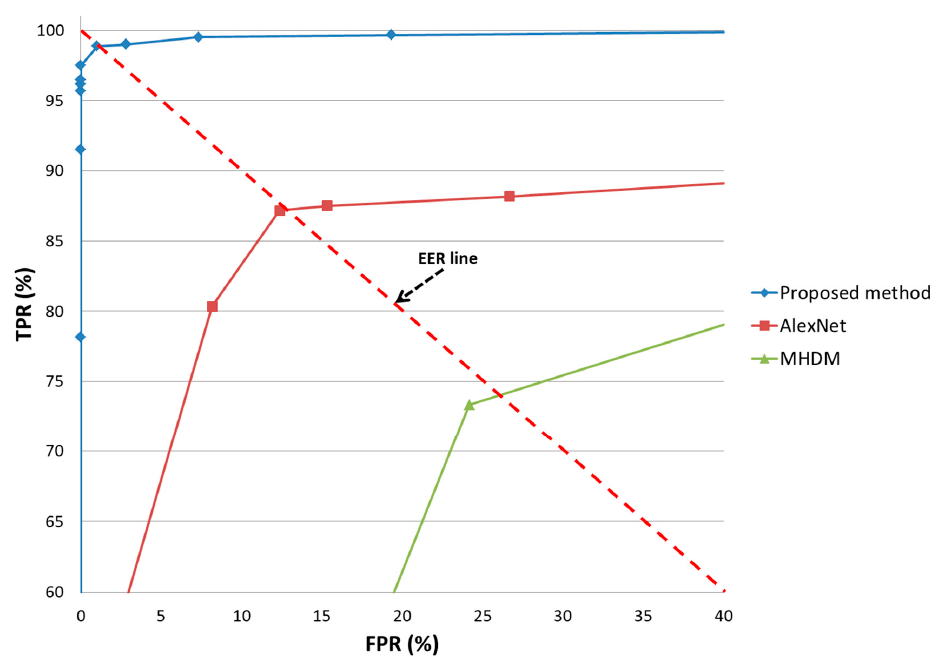
Figure 14. Receiver operating characteristic (ROC) curves of proposed method and its comparison with previous methods.